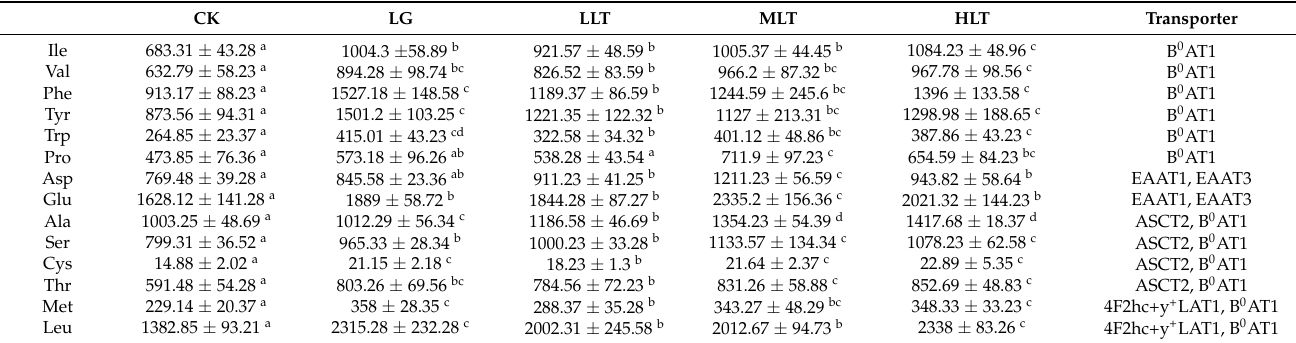
Table 3. Effects of L-theanine on amino acid content in mouse jejunum. CK (control), HLT